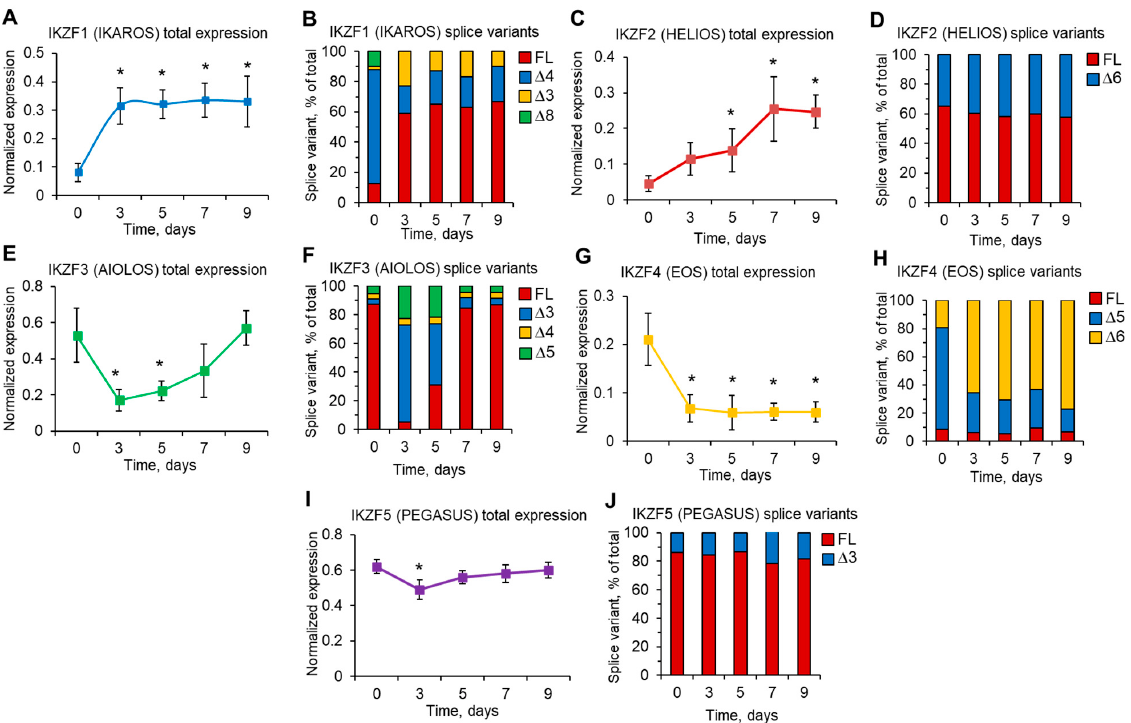
Figure 5. Expression profiles of IKAROS family zinc finger gene members and their splice variants during the time course of eTreg maturation ex vivo. The expression levels of total ( A ) IKZF1 (IKAROS), ( C ) IKZF2 (HELIOS), ( E ) IKZF3 (AIOLOS), ( G ) IKZF4 (EOS) and ( I ) IKZF5 (PEGASUS) in proliferating cells. ( B , D , F , H , J ) Proportions of corresponding splice variants. n = 4. * p ≤ 0.05 vs. initial cells at 0-day time-point. ∆ indicates the deletion of the relevant exon.